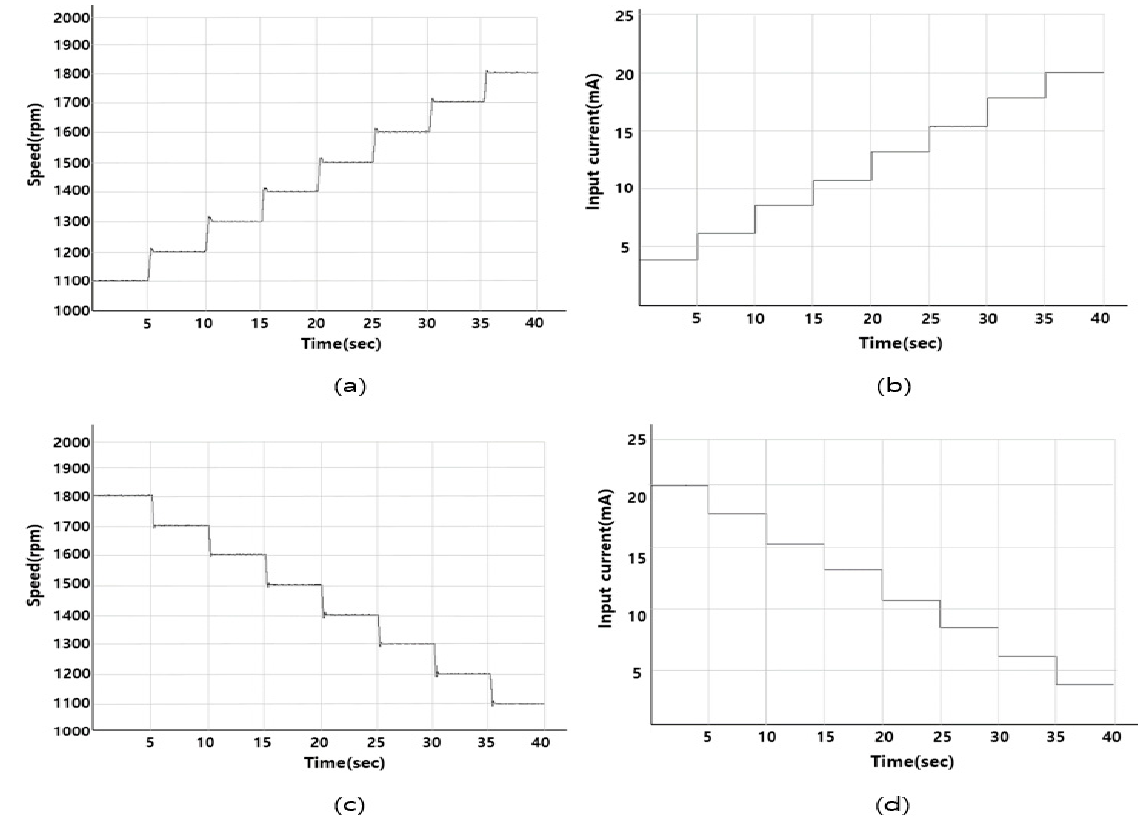
Figure 14. The output result of speed when the generator speed increases( a ), decreases( c ) and ( b ) is the output result of the potentiometer input current with respect to increasing speed, ( d ) is the output result of the potentiometer input current with respect to decreasing speed.